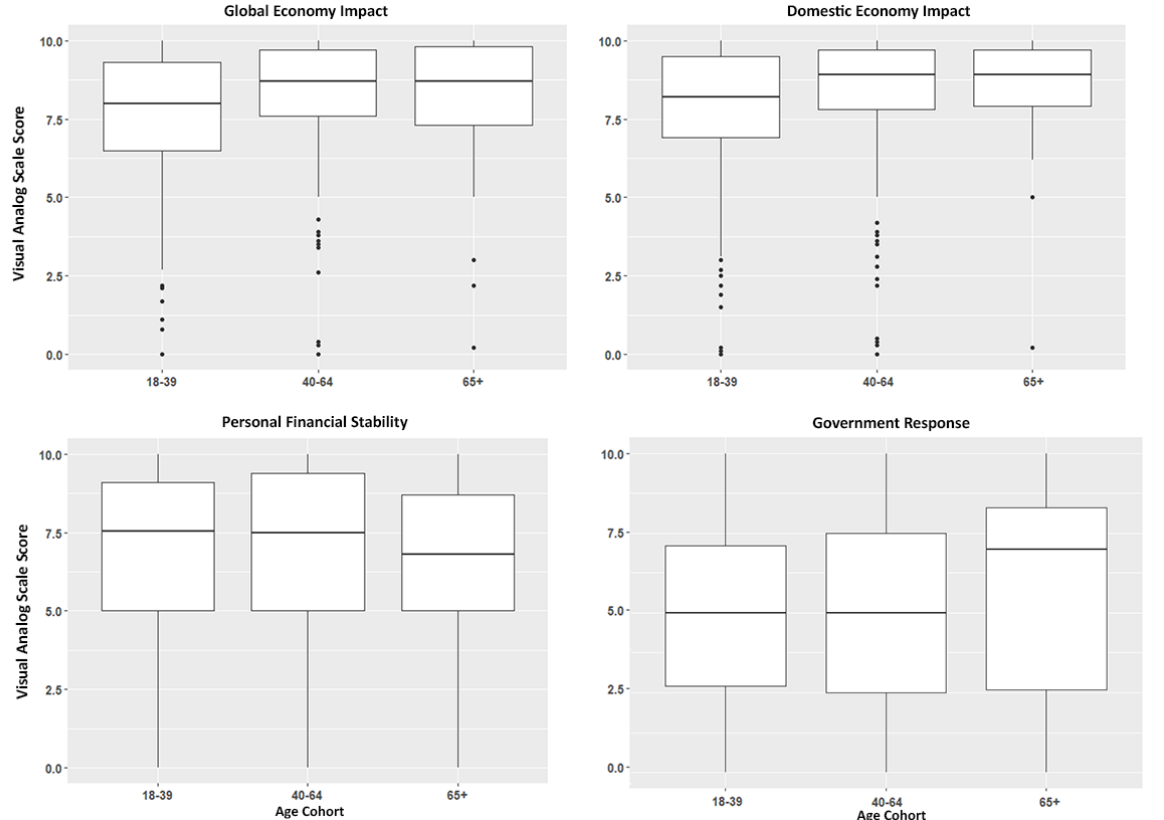
Figure 4. Box and whisker plots depicting the distribution and median of visual analog scale scores across all study participants with respect to age cohorts in response to how concerned individuals are about the negative impact of COVID-19 on the overall global economy (with 0 representing no concern at all and 10 the most concern), how concerned individuals are about the negative impact of COVID-19 on the overall US economy, how concerned individuals are about the negative impact of COVID-19 on personal financial stability, and how appropriately do individuals believe the US government has responded to the COVID-19 pandemic (where 0 indicates that they do not think the government or Centers for Disease Control and Prevention [CDC] has responded appropriately at all and 10 indicates that they think the government and CDC have responded